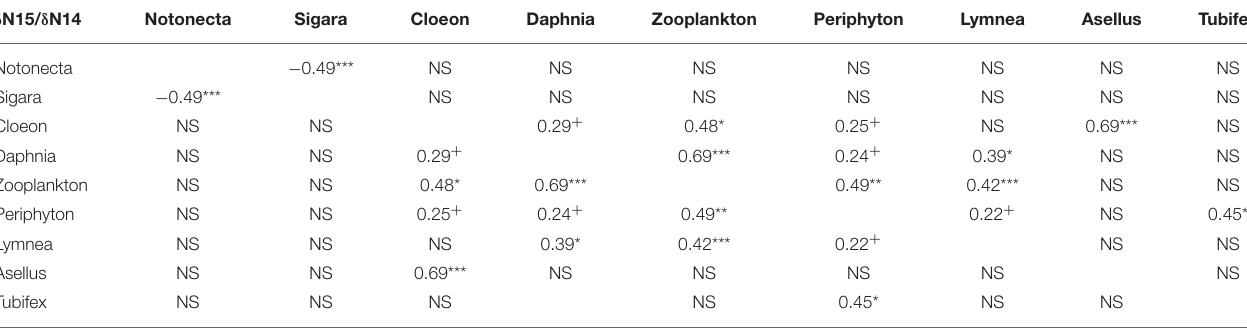
TABLE 2 | Pairwise correlation coefficients between nitrogen isotopes of all species in the experiment. δ N15/ δ N14